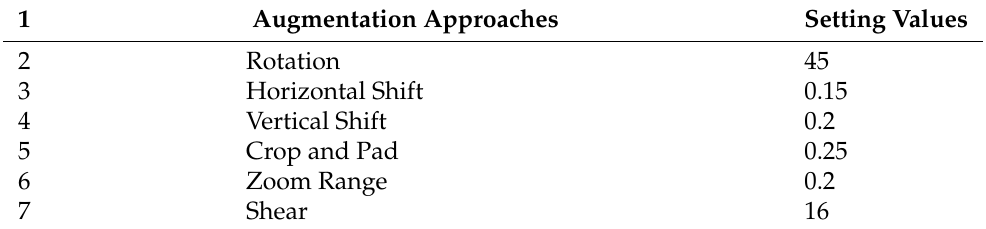
Table 1. Augmentation scheme applied in the proposed method.